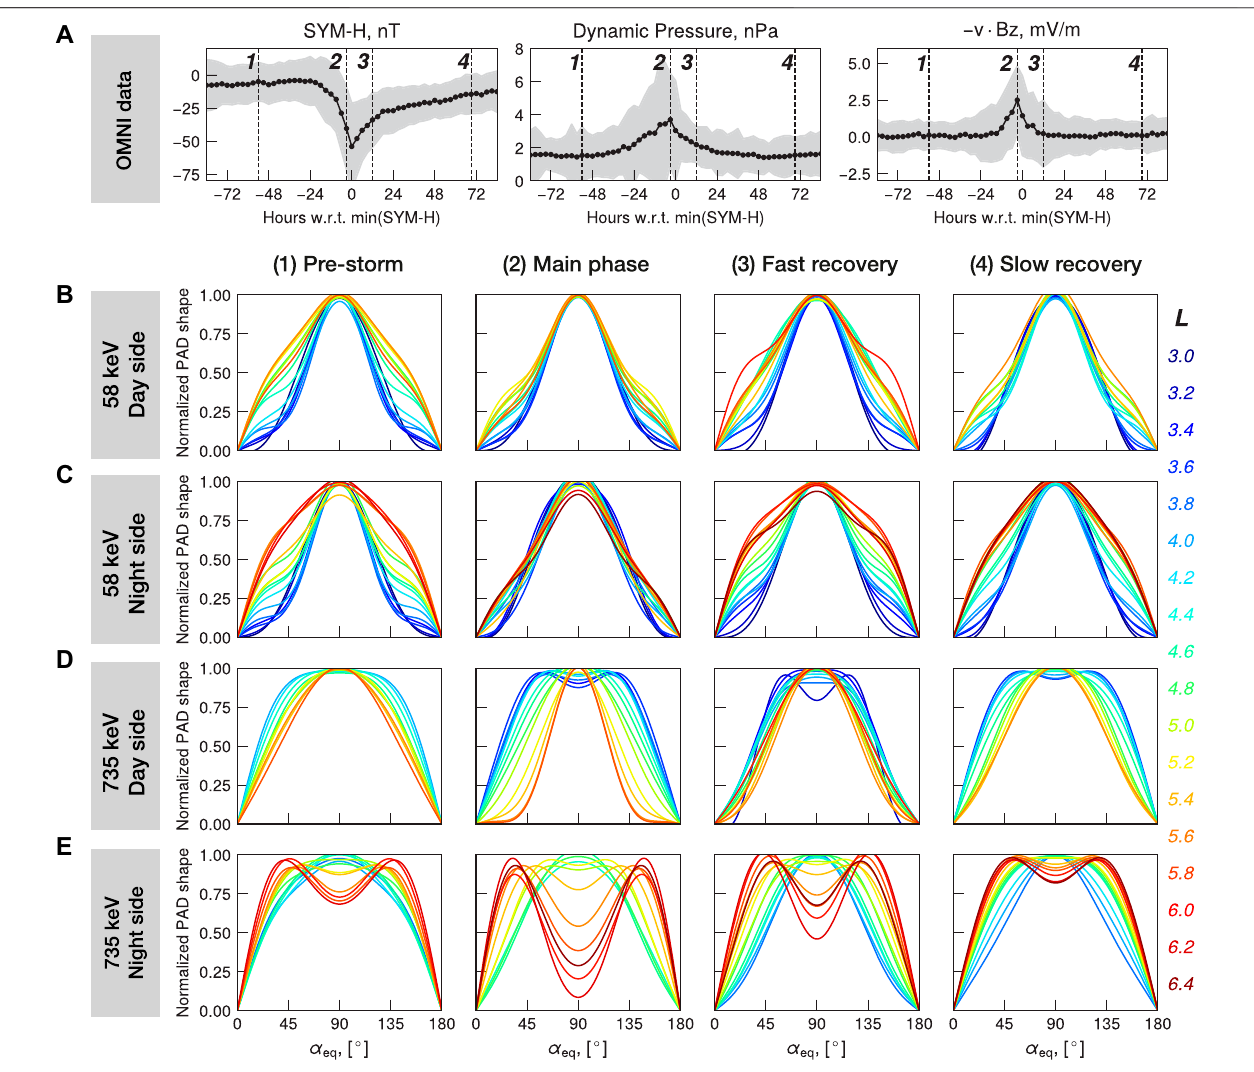
FIGURE 4 | (A) Superposed SYM-H index, SW dynamic pressure and electric fi eld. The dashed lines denote epochs at which the PAD shapes are shown below. (B) NormalizedPADshapesof58 keVelectrons for4phases ofthestorm atdayside MLT.ThelinesarecoloredbytheLmvaluesshown inalegend below. (C) Sameas (b) but for the nighttime MLT. (D) Normalized PAD shapes for 735 keV electrons at dayside, and (E) at